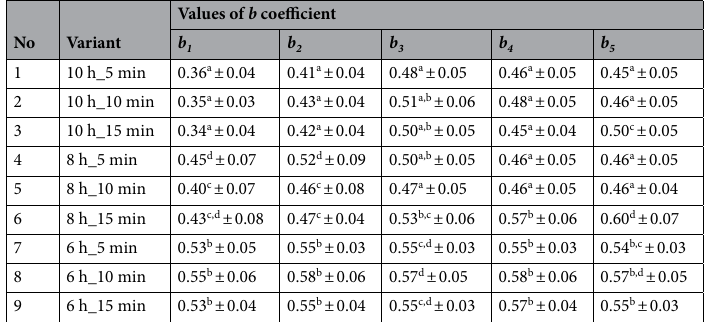
Table 5. Mean values of the b coefficient and standard deviations for the five steps of the studied process variants. a, b, c, d – homogeneous